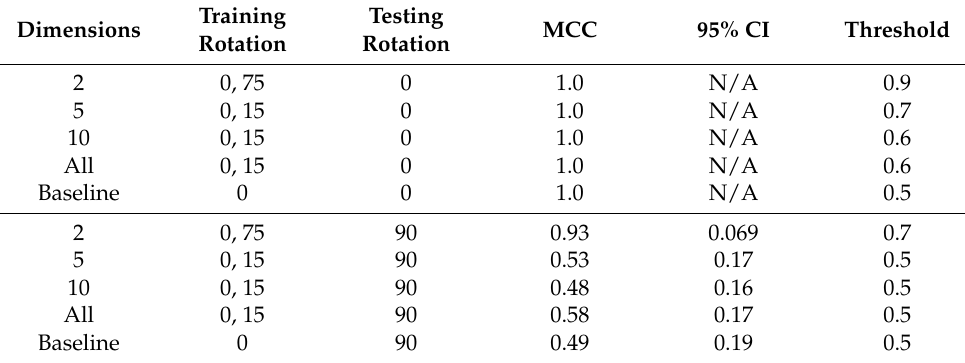
Table 5. C-band results tabulating unet model training data, testing data, the peak MCC performance with 95% confidence interval (CI), and the corresponding